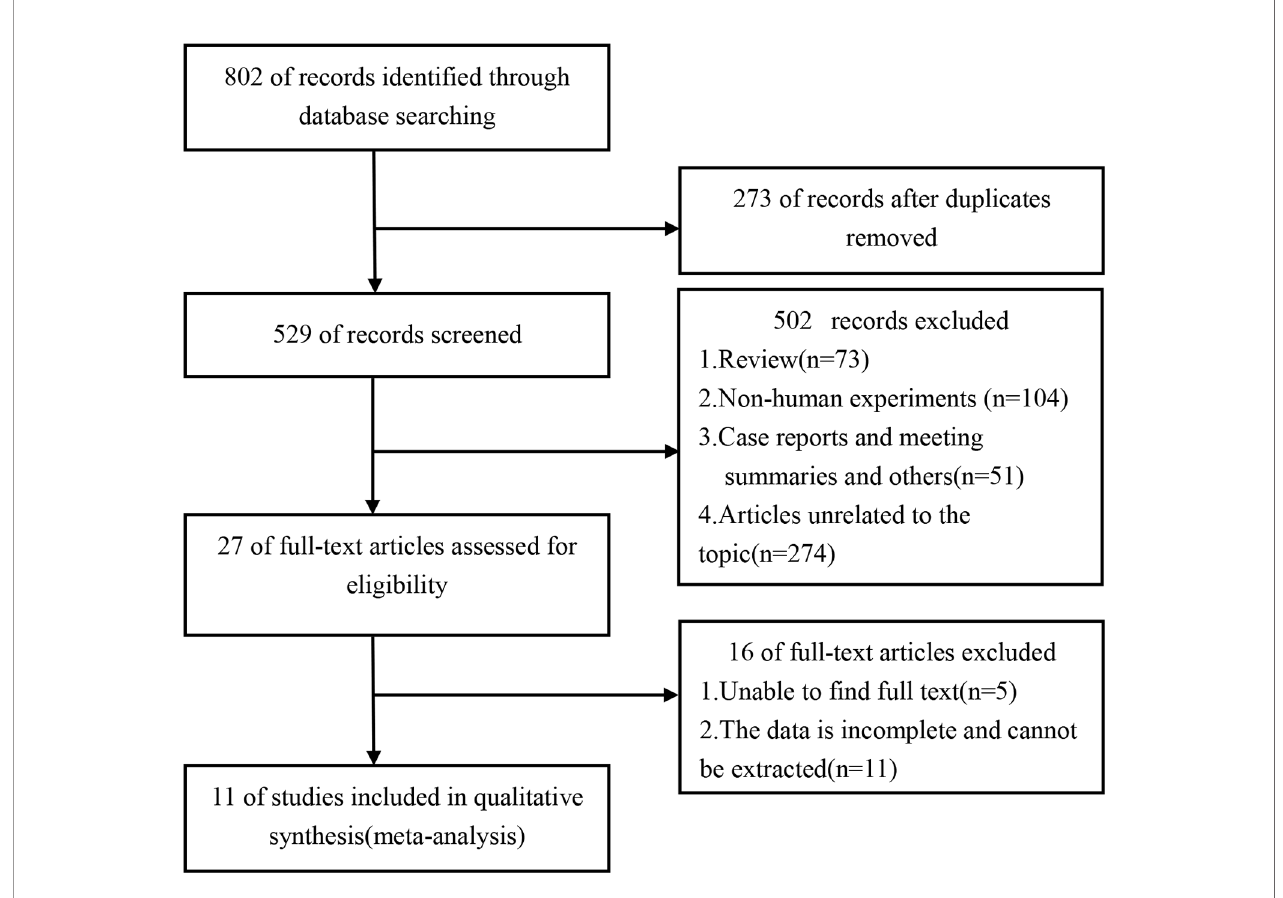
FIGURE 1 | Flowchart of the study selection process.